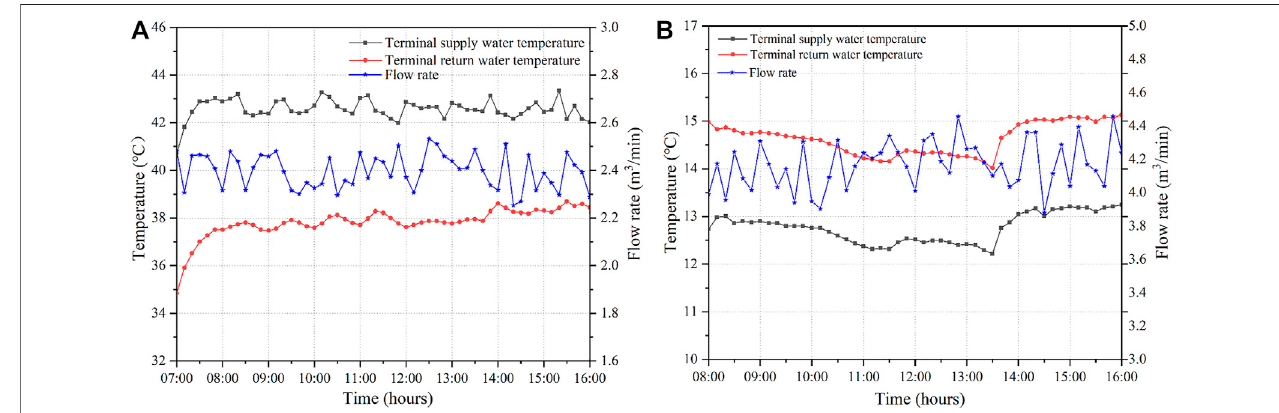
FIGURE 5 | Temperature and fl ow rate of terminal supply-return water as a function of time during (A) operation in heating period (January 26, 2017) and (B) operation in cooling period (July 6, 2017).